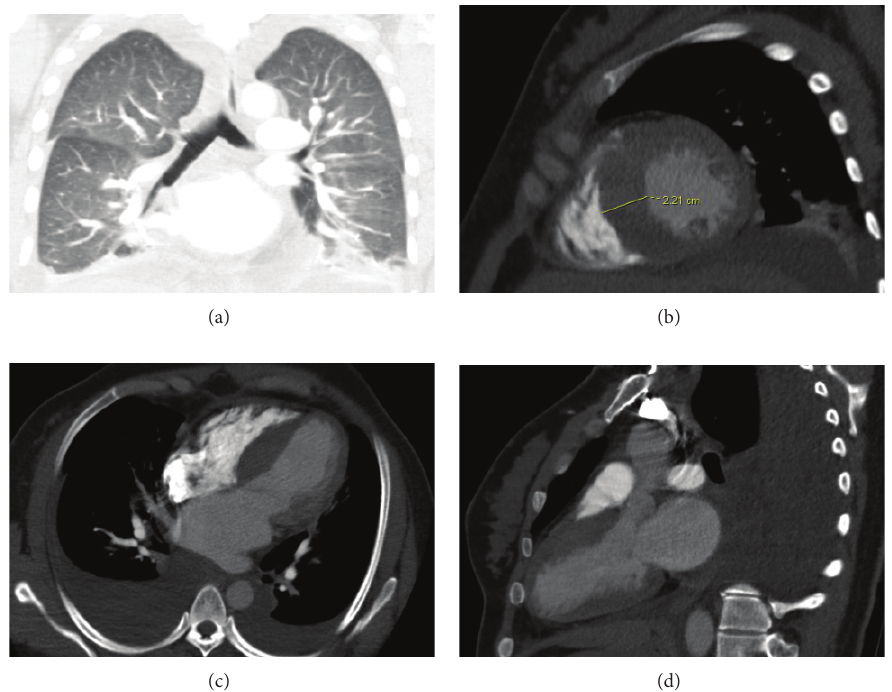
Figure 2: A 42-year-old female with hypertrophic cardiomyopathy and acute pulmonary edema. Findings: CT pulmonary angiogram ruled out pulmonary embolus and demonstrated diffuse, bilateral, and central peribronchovascular ground glass opacities and pleural effusions in keeping with pulmonary edema (coronal image, lung windows, (a)), thickening of the interventricular septum measuring up to 22mm, and left atrial enlargement (cardiac reconstructions, short axis (b), 4-chamber view (c), and 3-chamber view (d)).